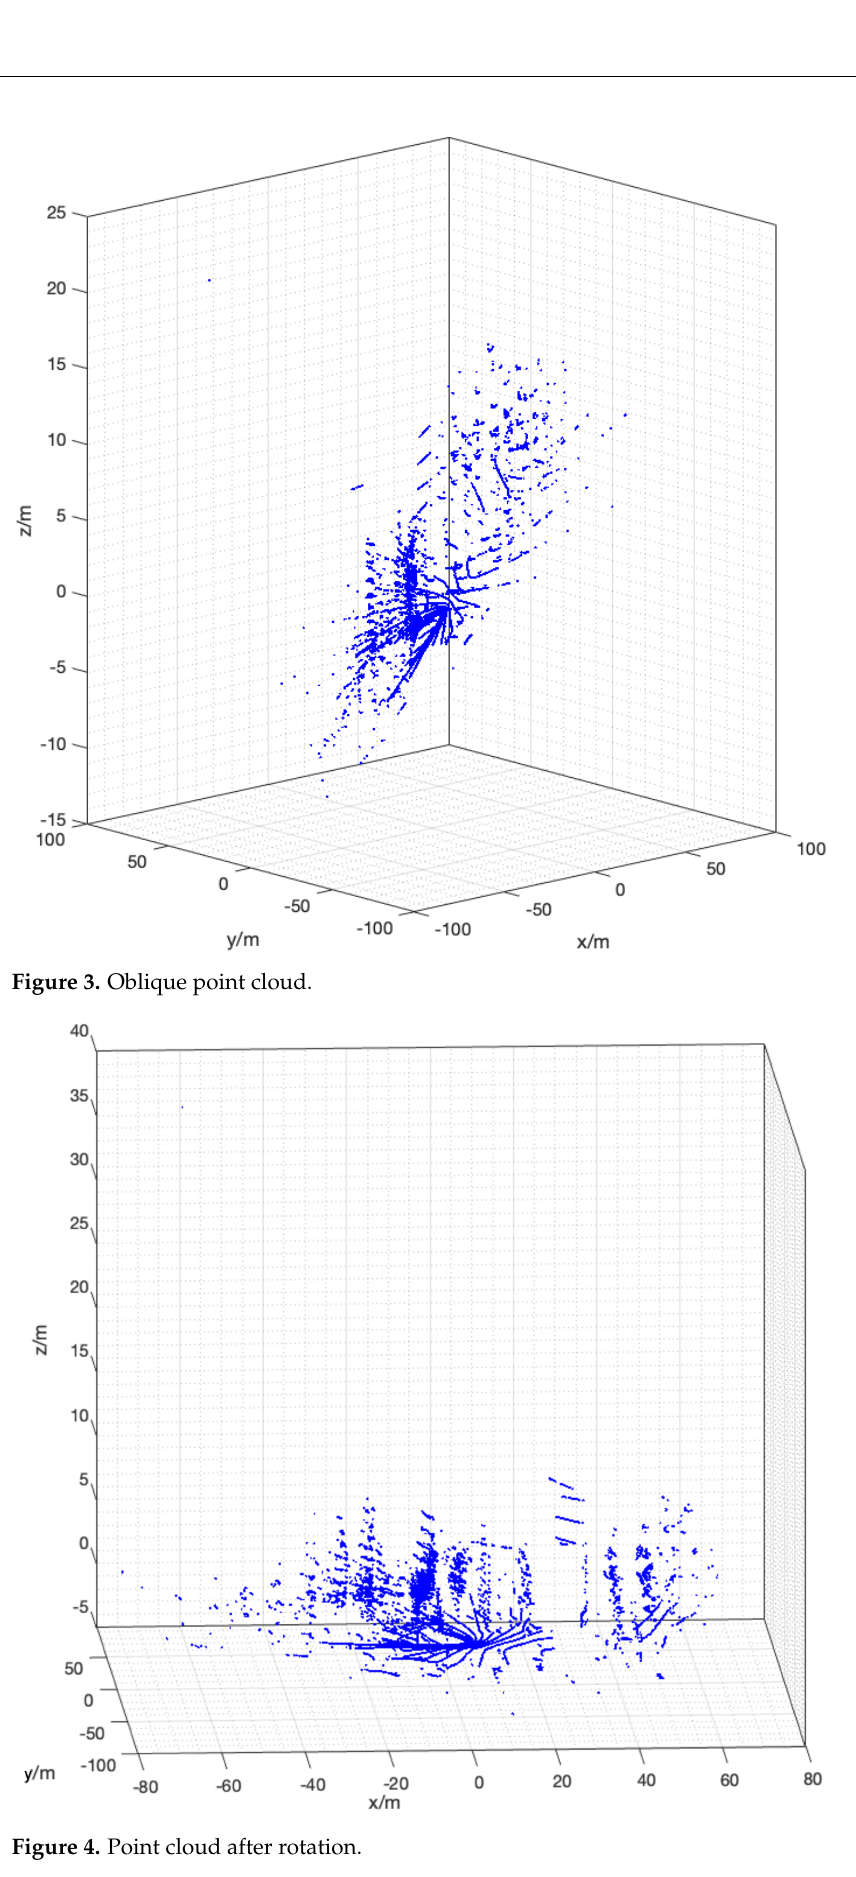
Figure 4. Point cloud after